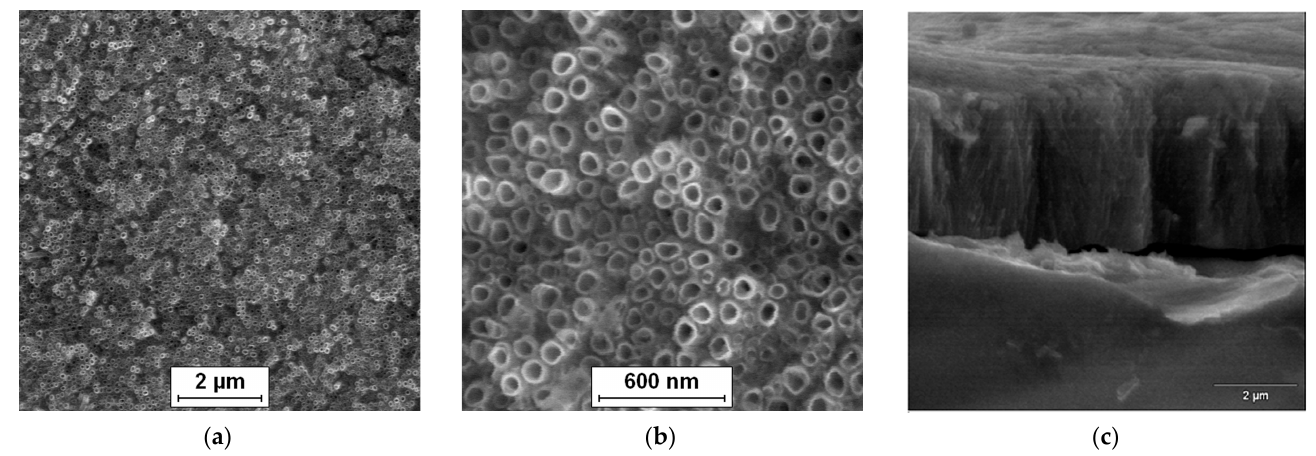
Figure 3. SE FE ‐ SEM image of the Ti–13Zr–13Nb alloy after anodizing in 1 M (NH 4 ) 2 SO 4 solution with 1 wt.% of NH 4 F at 20 V for 120 min: ( a ) On ‐ top general view of 2G ONTs layer; ( b ) View of 2G ONTs layer in a selected micro ‐ region; ( c ) Fracture of 2G ONTs layer [14].